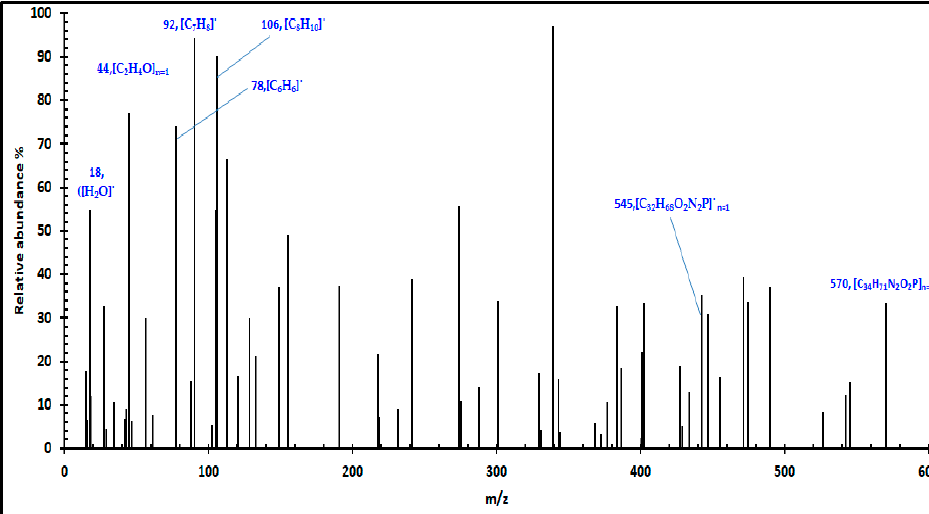
Figure 6. Characterization of PPVP composite by Mass Spectrometry.